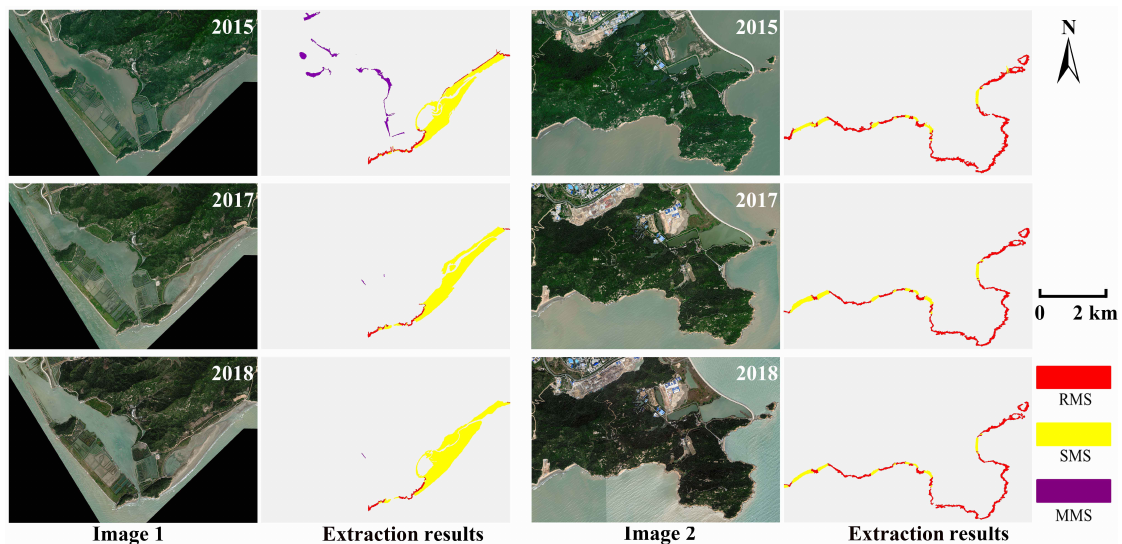
Figure 14. Tidal flat wetlands extraction results of the proposed